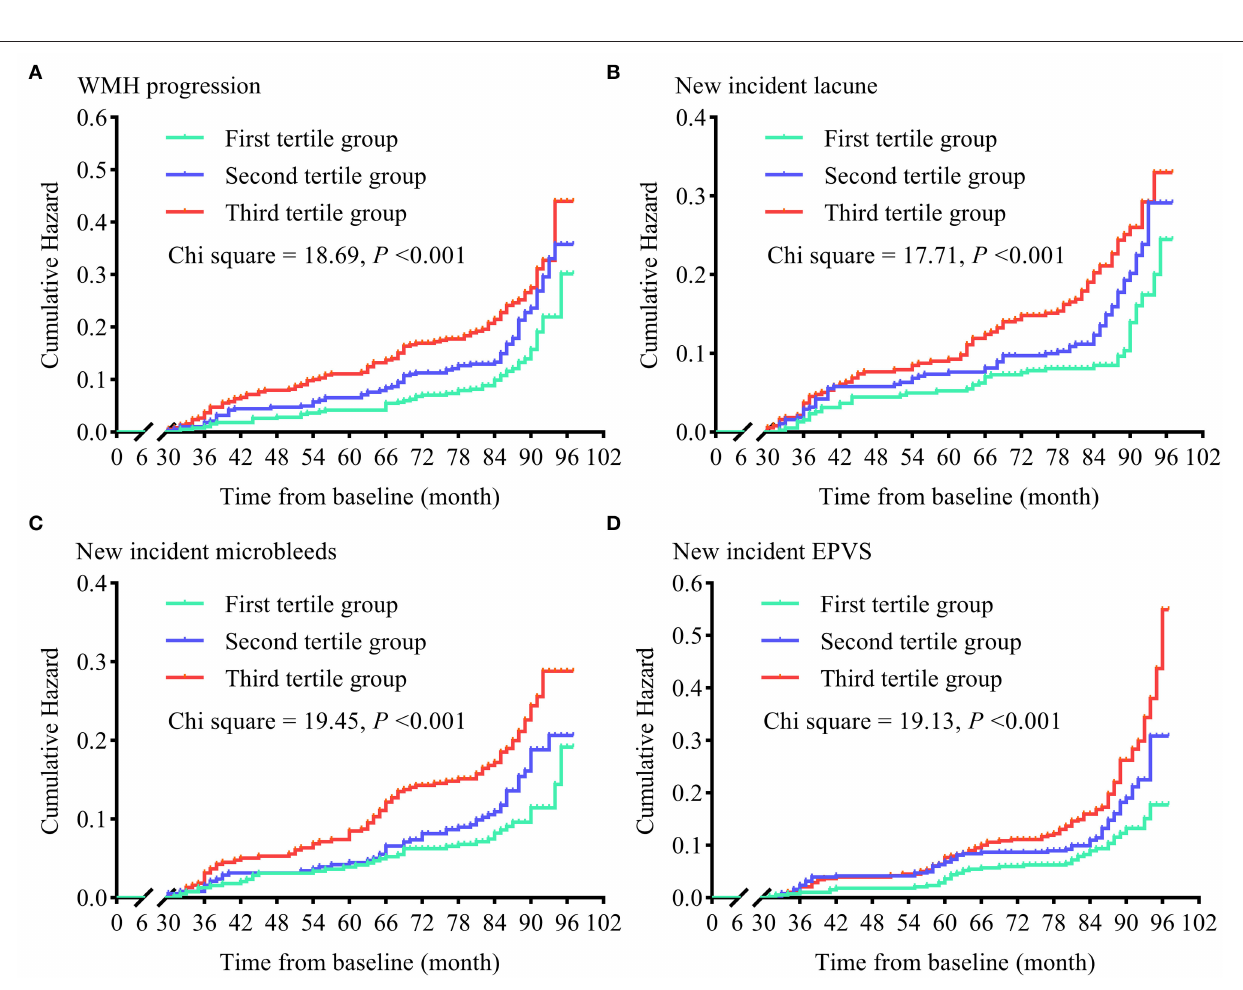
Frontiers in Neurology |